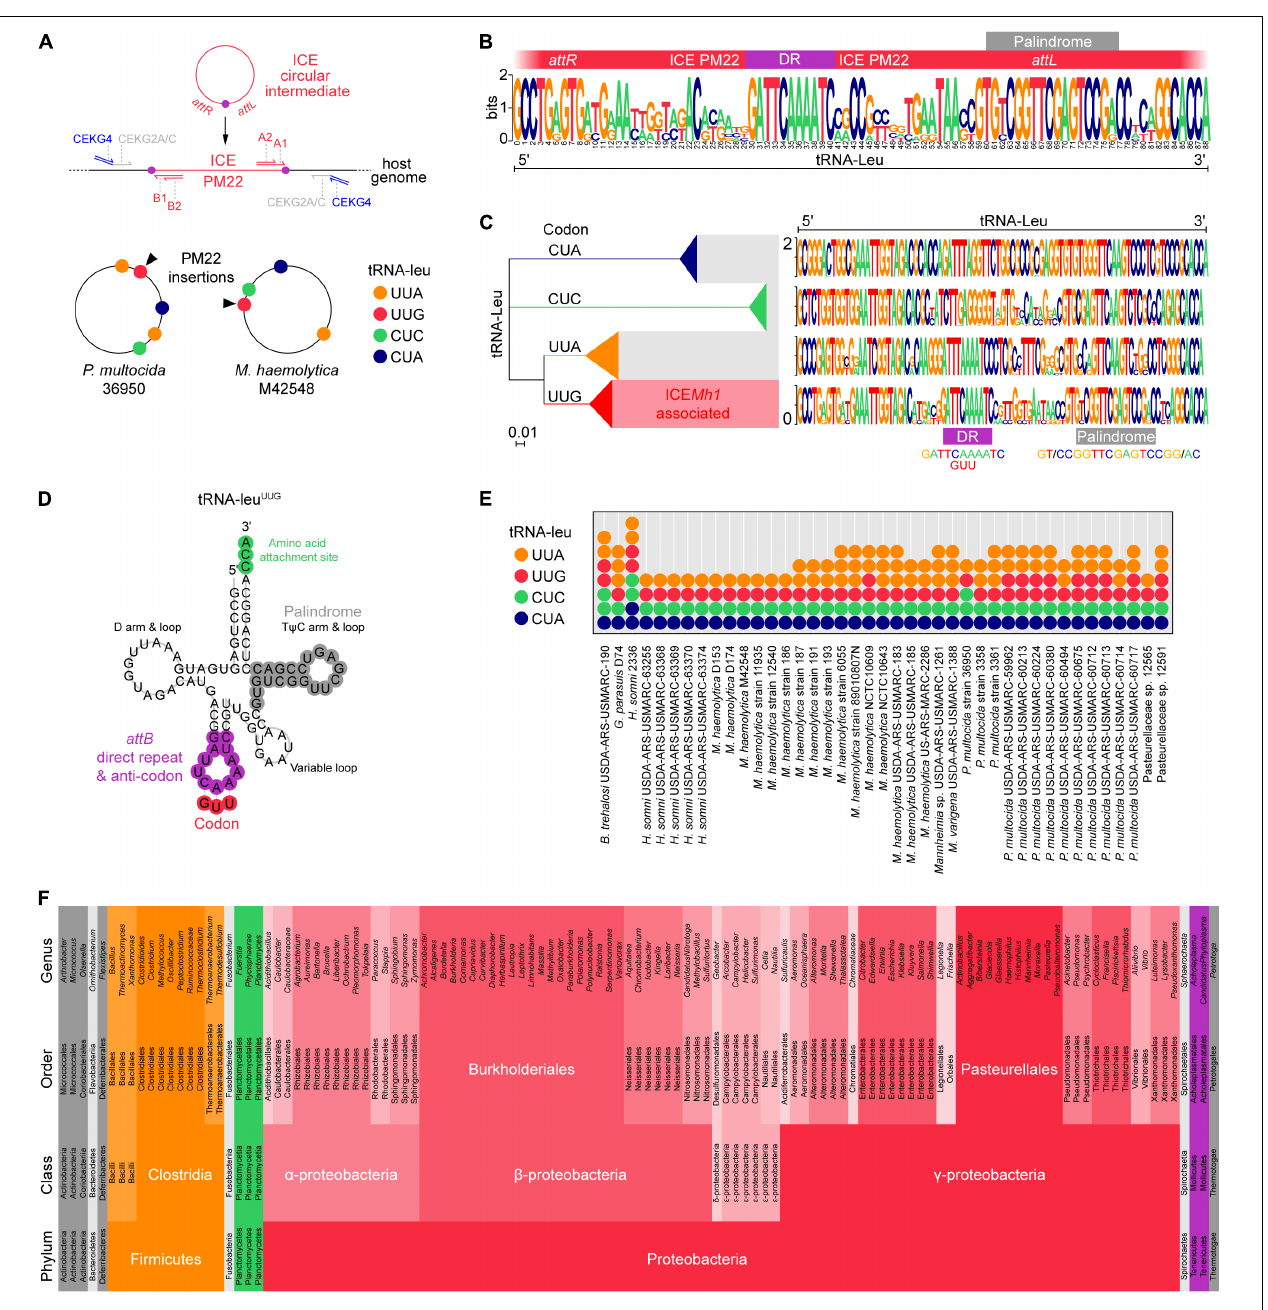
FIGURE 2 | Identification of tRNA-leu UUG as the putative attB insertion site of ICE Mh1 -like elements and predicted host range. (A) Schematic for ICE orientation and random PCR mapping of ICE Mh1 PM22 junctions in 18 Mannheimia haemolytica and 18 Pasteurella multocida transconjugants. ICE Mh1 PM22 insertions in every transconjugant were identical and aligned to a specific tRNA-leu in the genomes of P. multocida strain 36950 and M. haemolytica M42548. (B) Sequence logo of left and right MUSCLE-aligned junctions identified in 41 Pasteurellaceae harboring ICE Mh1 -like sequences. The left and right ends of ICE Mh1 -like variants contain a conserved direct repeat (DR; 5 (cid:48) -GATTCAAAATC-3 (cid:48) ) attL conserves the tRNA T ψ C loop’s imperfect palindrome (5 (cid:48) -CGGTTCGAGTCCG-3 (cid:48) ). The attL and attR sites are designated with respect to ICE Pmu1 in Michael et al. (2011b). (C) Neighbor-joining tree of all tRNA-leu from 41 Pasteurellaceae harboring ICE Mh1 -like sequences. All ICE Mh1 -like insertions were associated with tRNA-leu UUG . (D) Predicted structure of tRNA-leu UUG showing presumptive ICE Mh1 attB attachment site (also encoding the tRNA anticodon) and palindrome. (E) Frequencies of tRNA-leu codon types in 41 Pasteurellaceae harboring ICE Mh1 -like sequences. (F) Predicted host range of ICE Mh1 -like elements based on tRNA-leu UUG alignment by BLAST and strict (100% identity) conservation of direct repeat and palindrome. Colors are arbitrary.